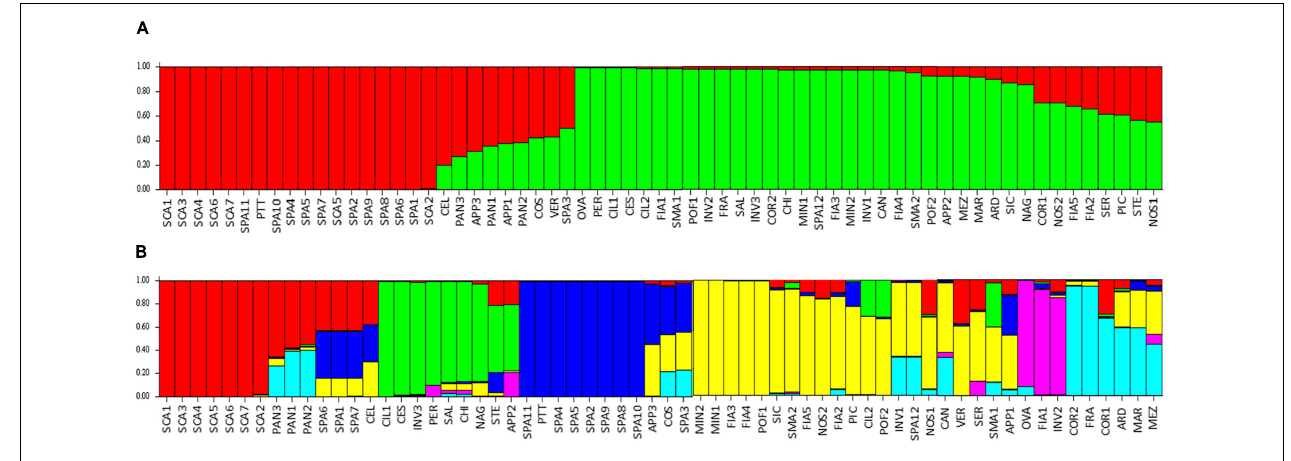
FIGURE 9 | Estimated population structure: each individual is represented by a vertical bar, which is partitioned into colored segments that represent the individual estimated levels of the two (A) or six (B) clusters. Accessions’ abbreviations are listed in Supplementary Table 1